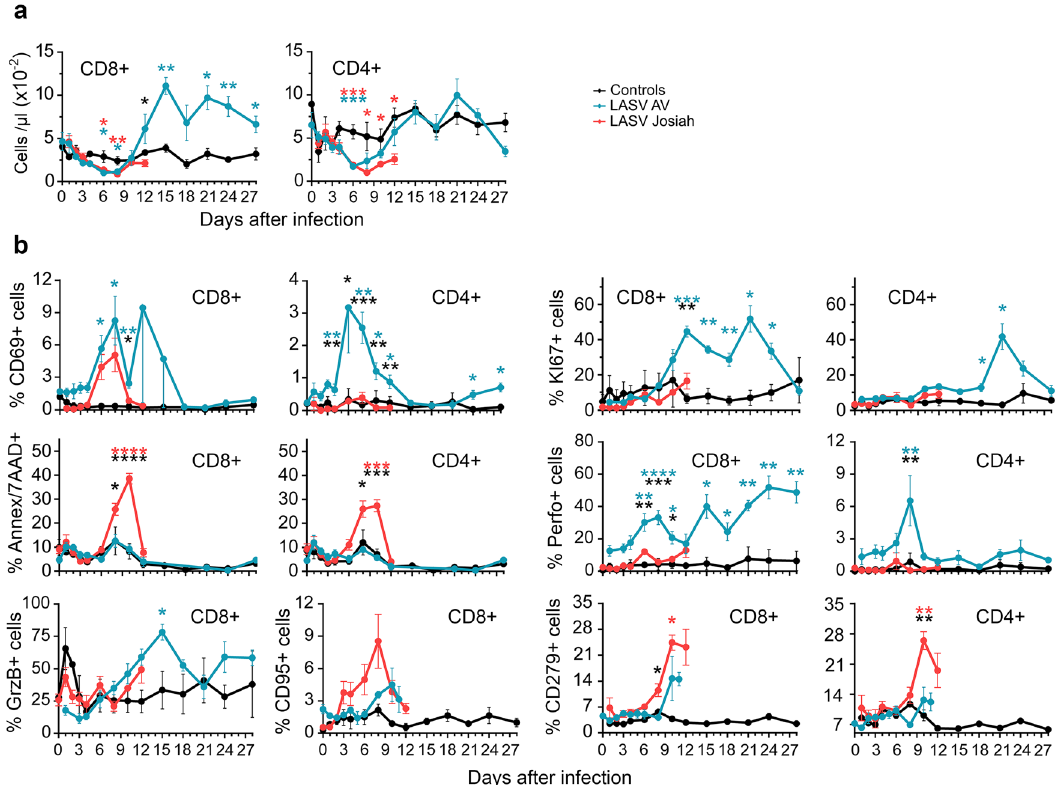
Fig. 6 Analysis of T-cell responses in PBMC after LASV challenge. a The number of CD8 + and CD4 + T cells in the blood is presented according to the time after LASV infection. b The percentage of circulating CD8 + (left) and CD4 + (right) T cells expressing CD69, KI67, Annexin V and 7AAD (Ann/ 7AAD), perforin (Perfo), GrzB, CD95, or CD279 is shown according to the time after LASV infection. Results show the mean ± SEM of control ( n = 3), AV ( n = 4), and Josiah ( n = 6) animals. Statistical analyses were performed and are presented as in Fig. 1. Individual values can be found in Supplementary data